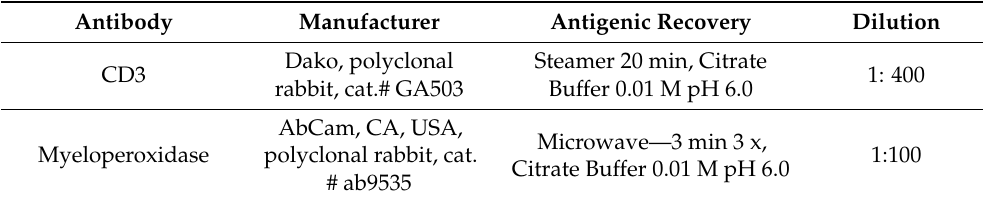
Table 1. Characteristics of antibodies used and antigenic recovery in the immunohistochemistry assays.